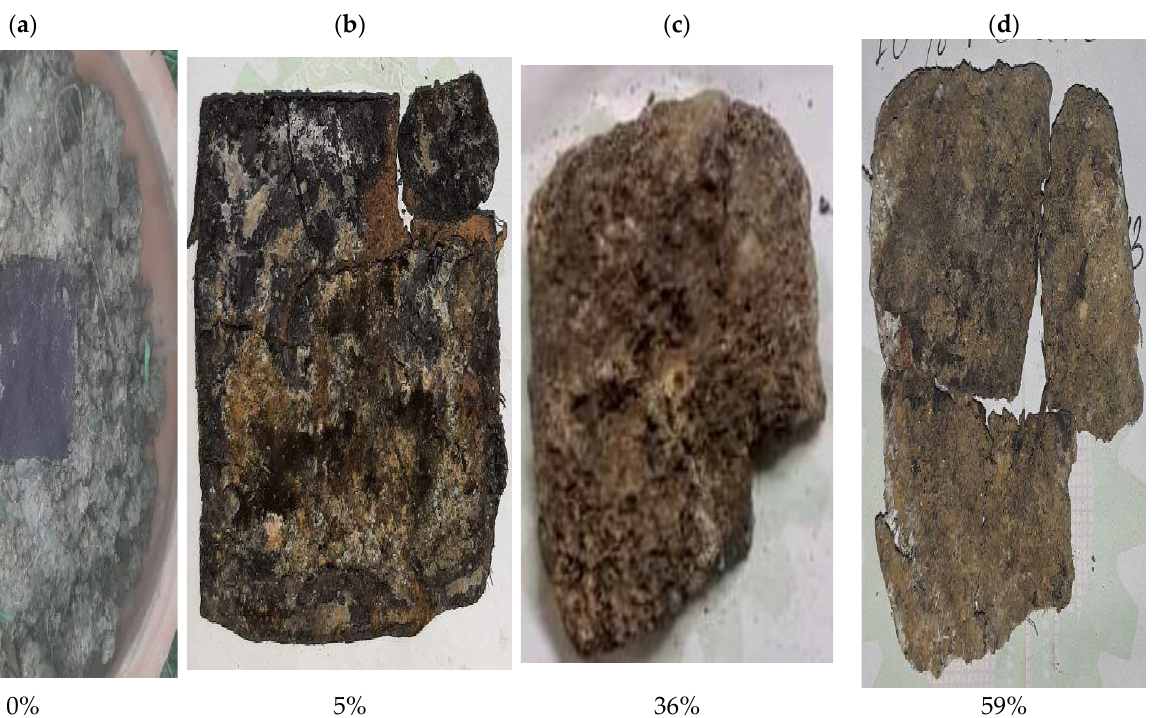
Figure 4. 10% fenugreek containing bio-composite degradation sample on ( a ) Day 1, ( b ) Day 7, ( c ) Day 15, and ( d ) Day 30.